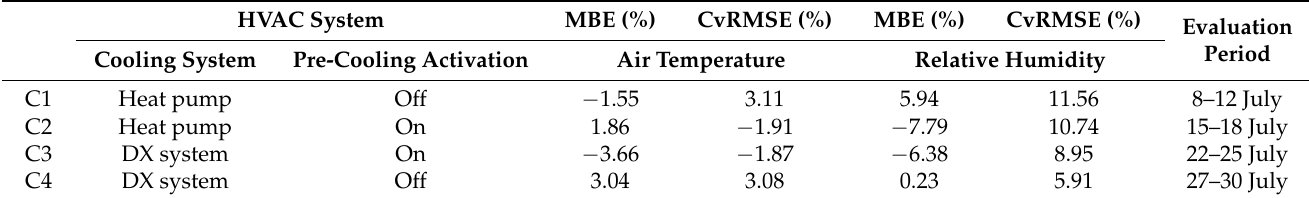
Table 5. HVAC system configurations and corresponding calibration indices for one building room.